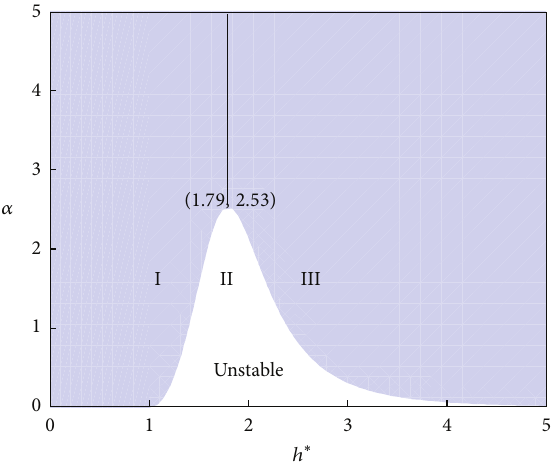
Figure 2: The synchronization transition